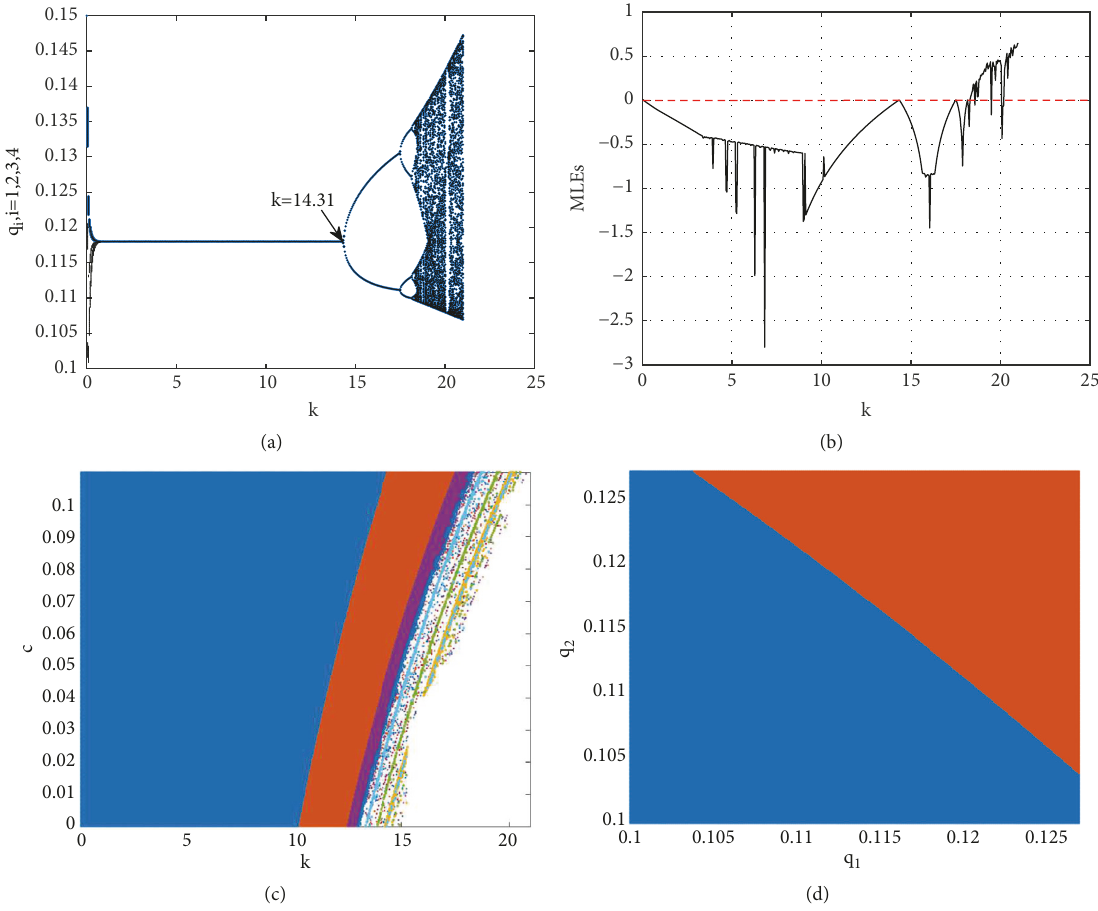
Figure 7: (a) Bifurcation diagram of system (20) with respect to 𝑘 at (𝑎,𝑐, 𝑞 0,1 ,𝑞 0,2 , 𝑞 0,3 , 𝑞 0,4 ,) = (0.7, 0.11, 0.19, 0.15, 0.13, 0.11) . (b) Maximum Lyapunov exponents with respect to 𝑘 at (𝑎,𝑐, 𝑞 0,1 ,𝑞 0,2 , 𝑞 0,3 ,𝑞 0,4 ) = (0.7, 0.11, 0.19, 0.15, 0.13, 0.11) . (c) 2D bifurcation in the (𝑘,𝑐) parameter plane at (𝑎, 𝑞 0,1 , 𝑞 0,2 ,𝑞 0,3 , 𝑞 0,4 ) = (0.7, 0.19, 0.15, 0.13, 0.11) . (d) The basin of attraction of the period 2-cycle (𝑎,𝑐,𝑘,𝛼,𝑞 3 , 𝑞 4 ) = (0.7, 0.11, 15, 0.5, 0.13, 0.11) .